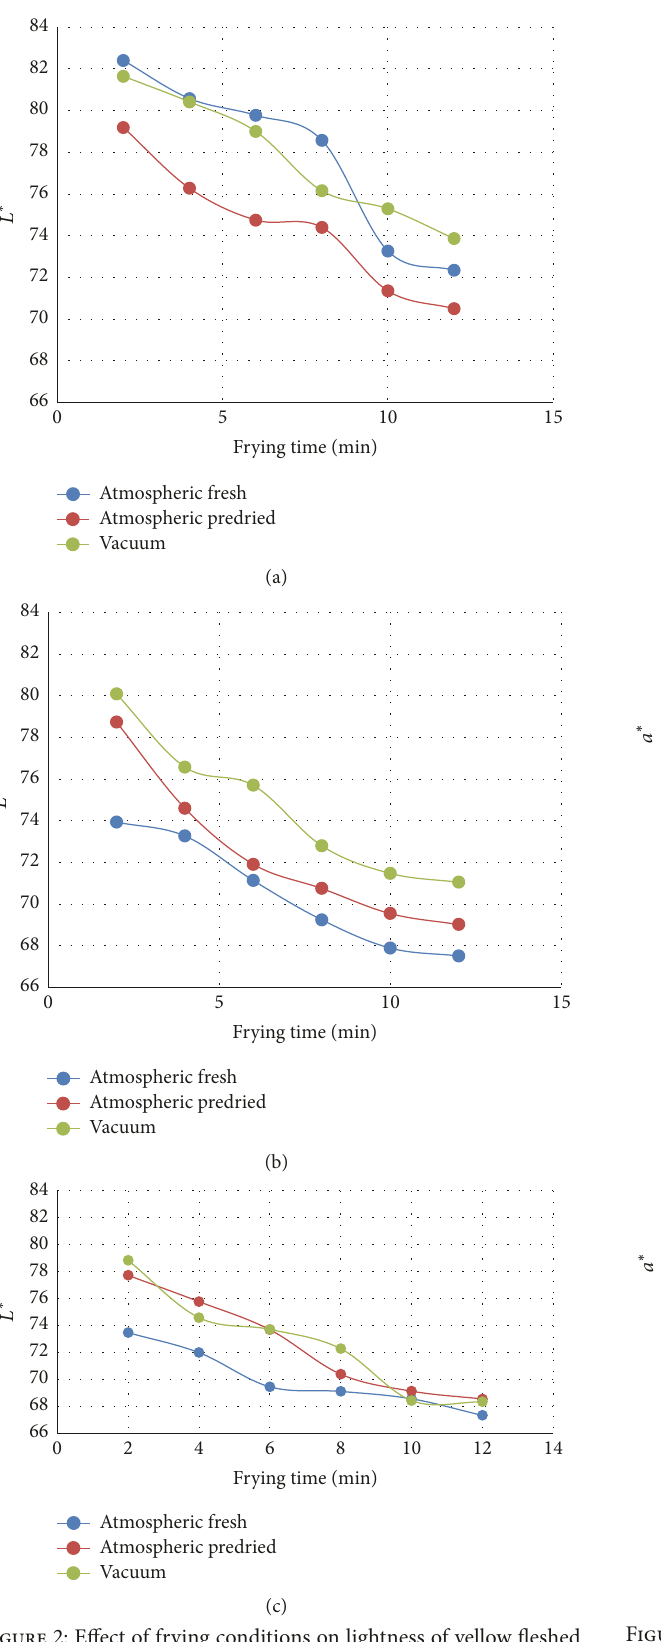
Figure 2: Effect of frying conditions on lightness of yellow fleshed cassava chips (YFCC) at different equivalent thermal driving forces (ETDF) of (a) 60 ∘ C, (b) 70 ∘ C, and (c) 80 ∘ C.